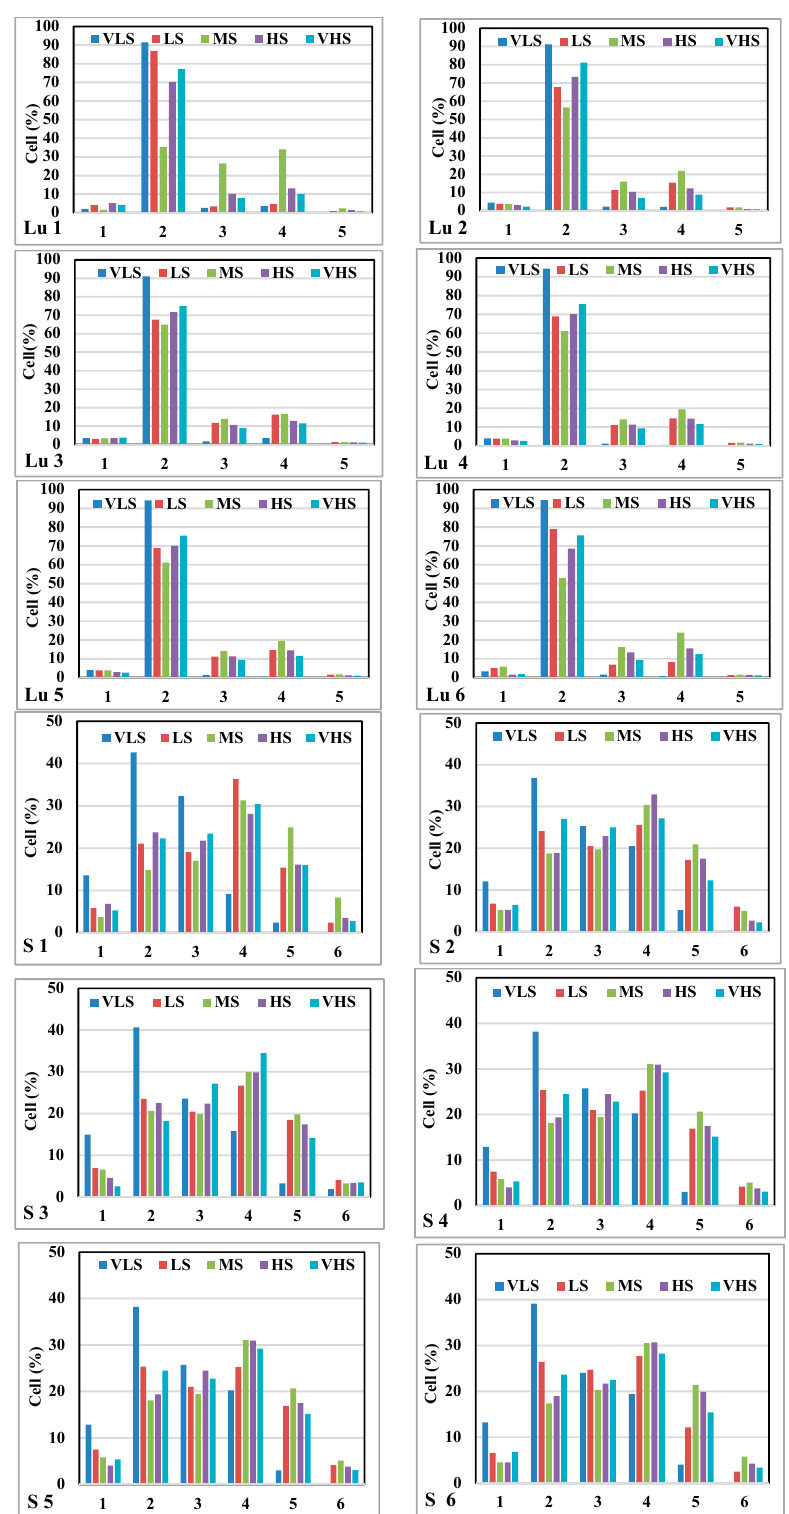
Figure 8. Histograms of gully susceptibility classes with the sixth most important factors: DR: distance to river; L: lithology; Gm: geomorphology; HG: hydrological group; Lu: land use; S: slope, 1: ADTree model; 2: Logistic Regression (LR) model; 3: Naïve Bayes Multinomial Updatable (NBMU) model; 4: Support Vector Machine-Radial Base Function (SVM-RBF) kernel model; 5: SVM-Polynomial kernel model and 6: RF-ADTree model. Sensors 2019 , 19 , x; doi: